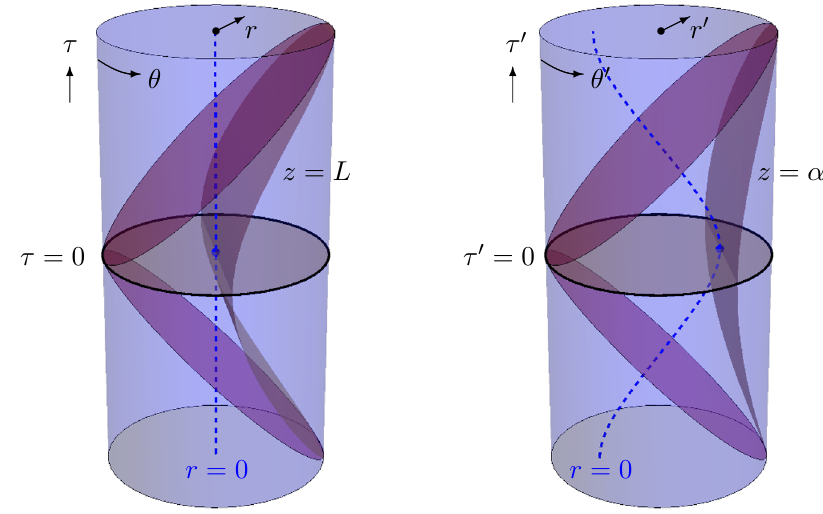
Figure 5 . Two global coordinate systems and their Poincar(cid:19)e patches. In the left (cid:12)gure we have plotted the original global frame, represented with coordinates ( (cid:28); r; (cid:18) ), where the particle lies at the origin r = 0. Specializing to a Poincar(cid:19)e patch maps this geodesic to z 2 = L 2 + t 2 , so the minimum approach to the boundary is z = L at t = 0. This surface is depicted in brown. In the right (cid:12)gure we have plotted the boosted global frame ( (cid:28) 0 ; r 0 ; (cid:18) 0 ) where the particle oscillates according to (3.23). Specializing to a Poincar(cid:19)e patch of this boosted frame maps the particle’s trajectory to z 2 = (cid:11) 2 + t 2